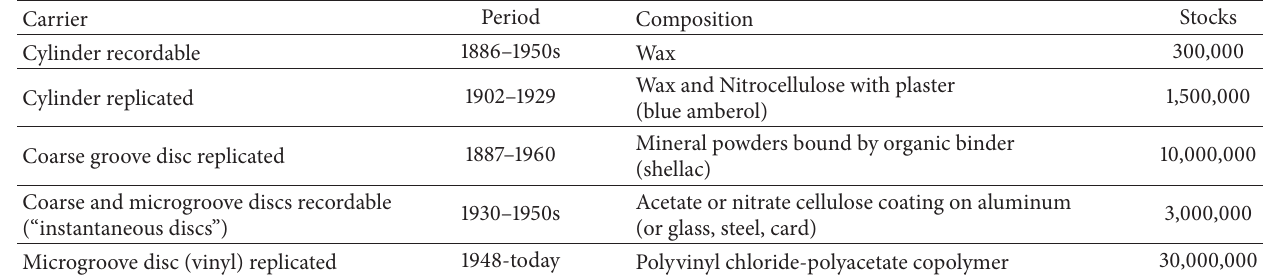
Figure 1: Scheme of the remediation process, in which three distinct steps can be observed, as well as the set of control procedures applied during the workflow. Each step is articulated in procedures and sub-procedures. Table 1: Typologies of analogue mechanical carriers.